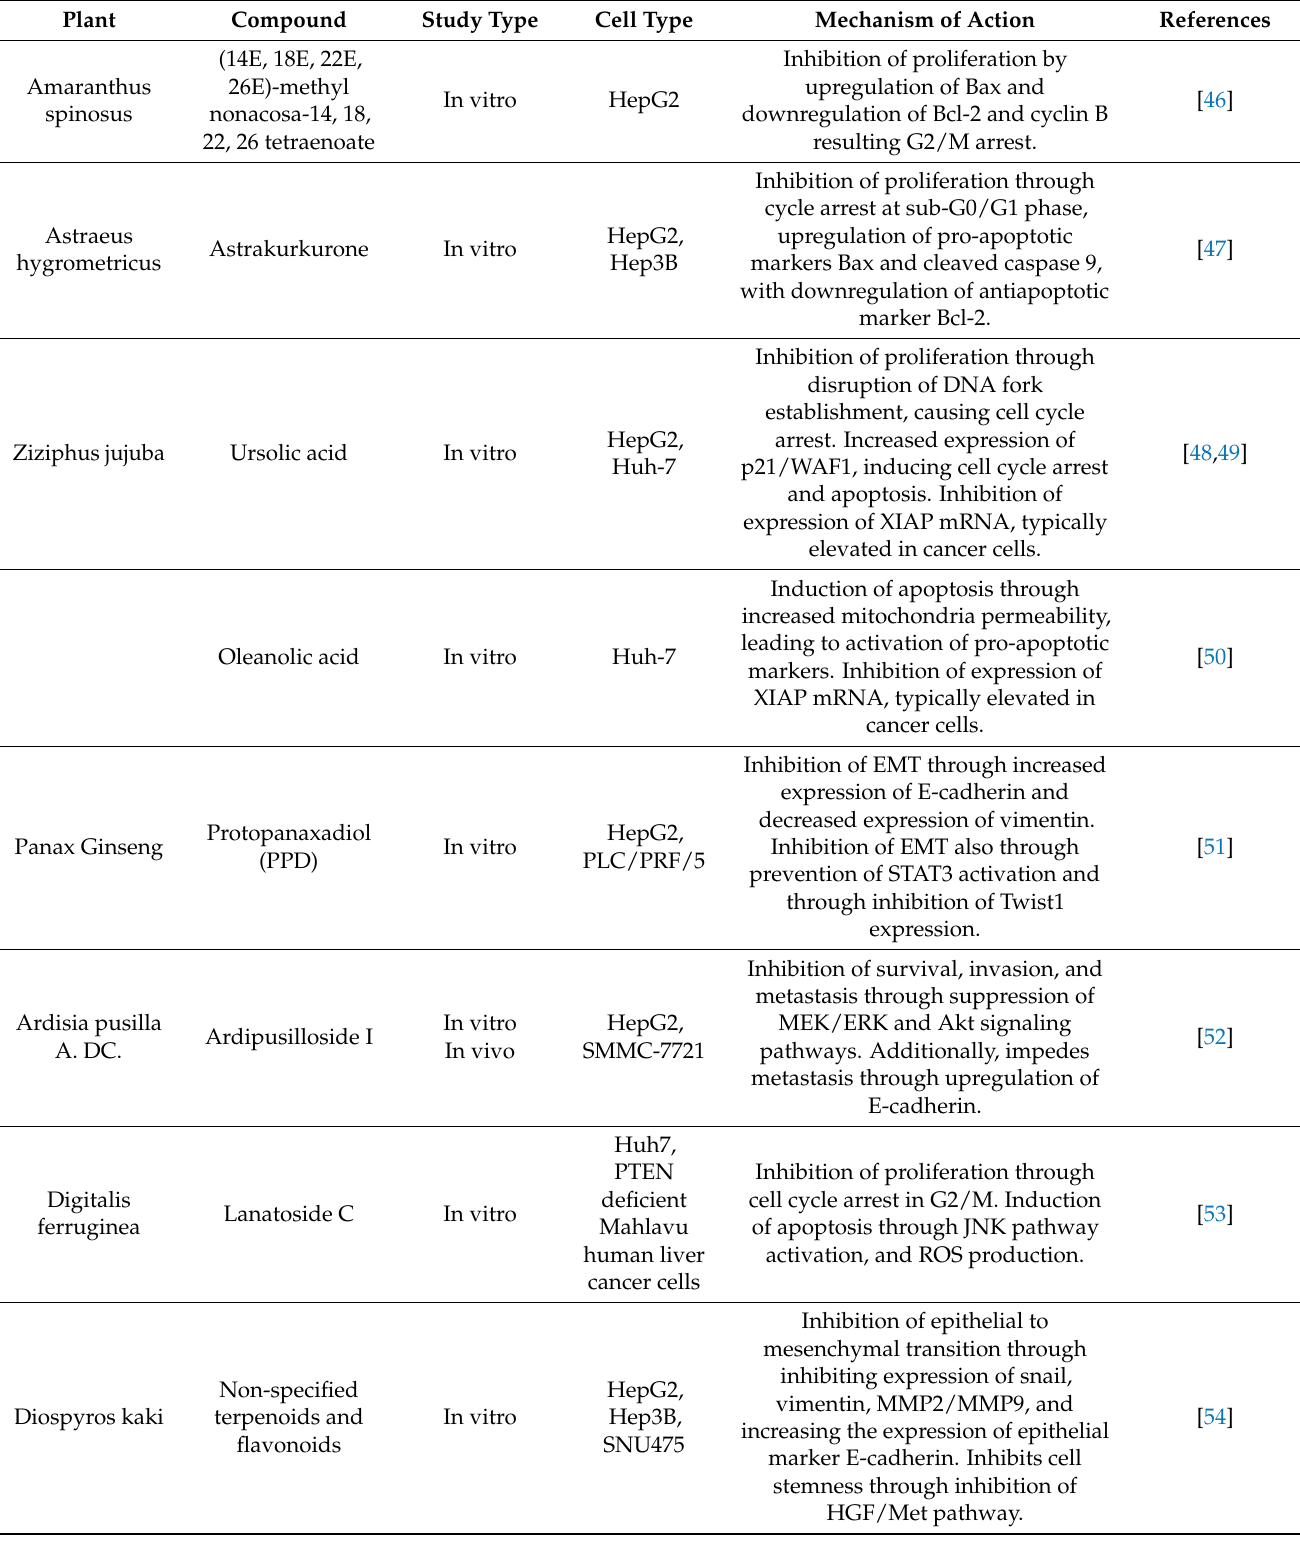
Table 1. List of natural compounds and their mechanism of action on hepatocellular carcinoma from preclinical studies. Plant Compound Study Type Cell Type Mechanism of